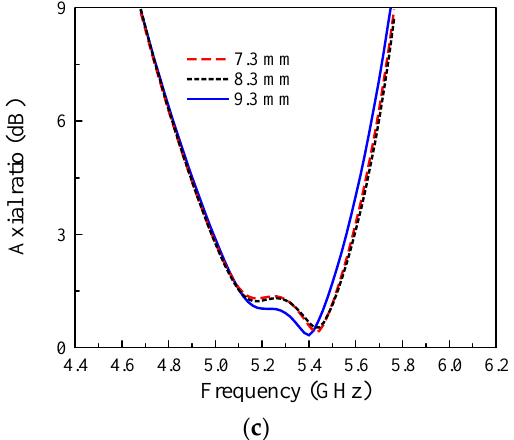
Figure 8. Simulated performance of the proposed MIMO antenna with different values of l f . ( a ) Re- flection coefficient (|S 11 |), ( b ) transmission coefficient (|S 21 |), and ( c ) axial ratio (AR).